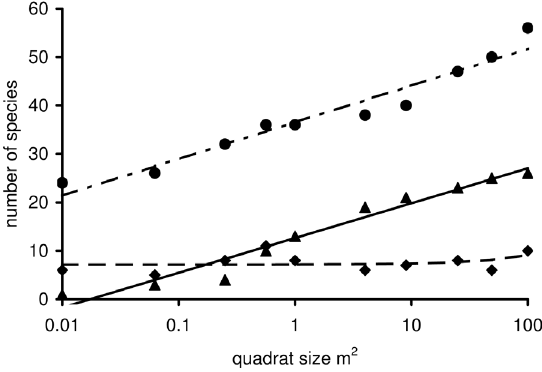
Figure 2. Case 1. Increasing size of sample unit (quadrat size).